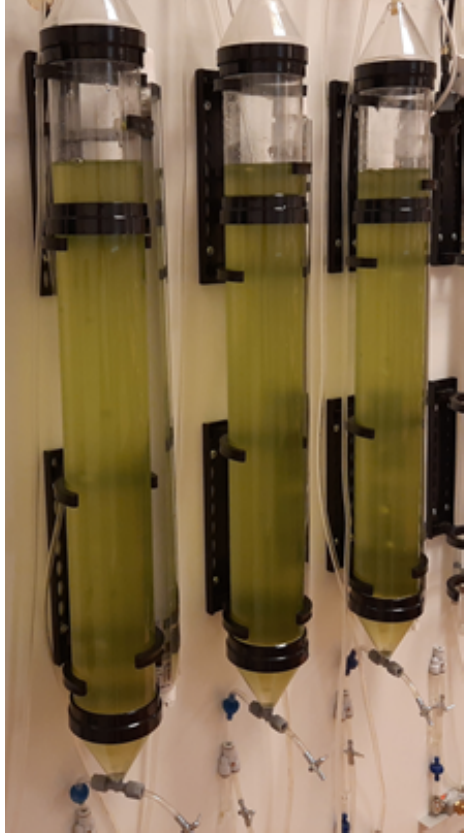
Figure 1. Vertical tubular photobioreactors used in the research.